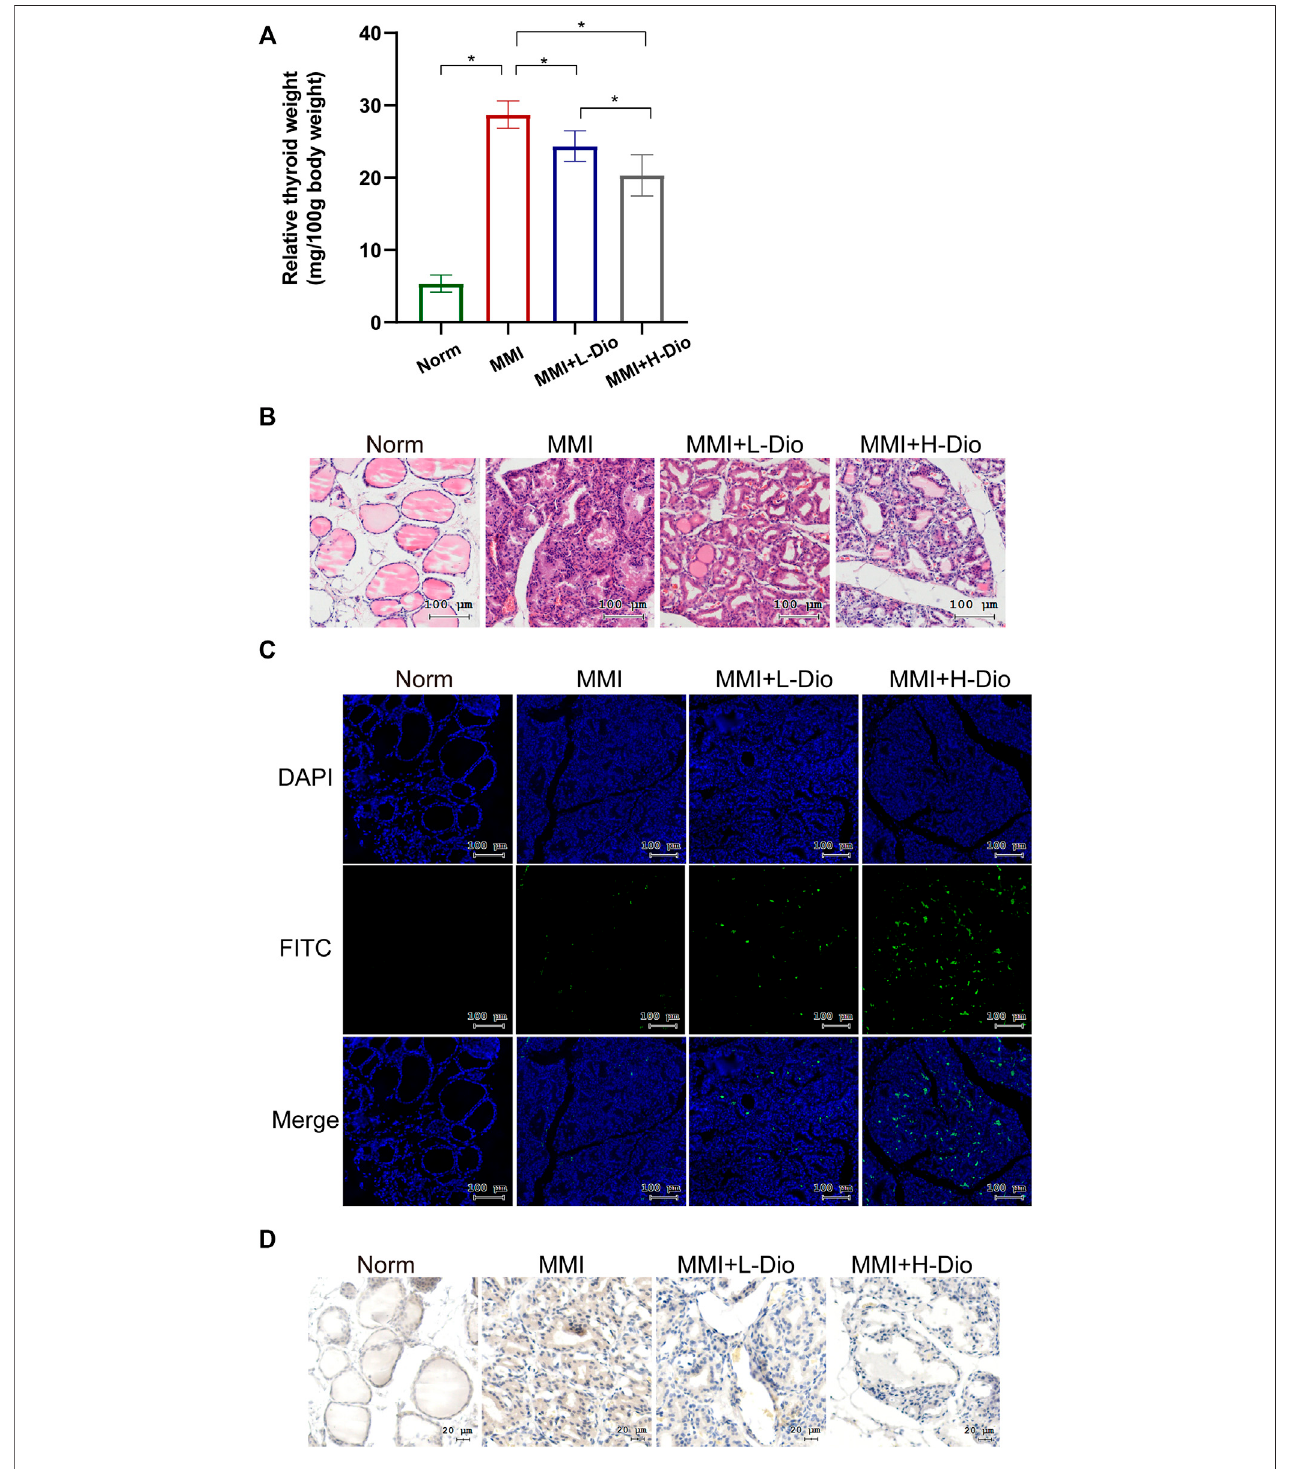
FIGURE 9 | Diosgenin could inhibit thyrocyte proliferation in MMI-induced rats. (A) The effects of diosgenin treatment on goiter. (B) After 3 weeks of diosgenin treatment, (A – D) refer to histological changes in thyroid glands stained with H&E (magni fi cation, × 200). (C) The TUNEL kit allows apoptotic cells to emit green light through the FITC channel. The nucleus is stained by DAPI. (D) Immunohistochemical staining of p-IGF-1R in the thyroid after 3 weeks of diosgenin treatment.